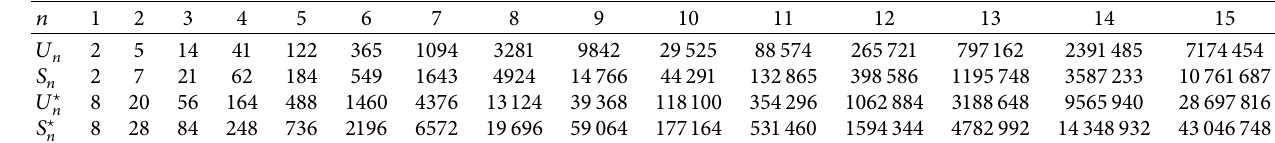
( x,y ) ) (a) and Card ( B ( x, y ) ) (b) over a sample of n ’s up to a product of 15 distinct primes. n | x ≥ 4 n n | x ∈ Z Table 1: U , S ; U ∗ , S ∗ n n n n based on a dataset of up to 15 distinct prime